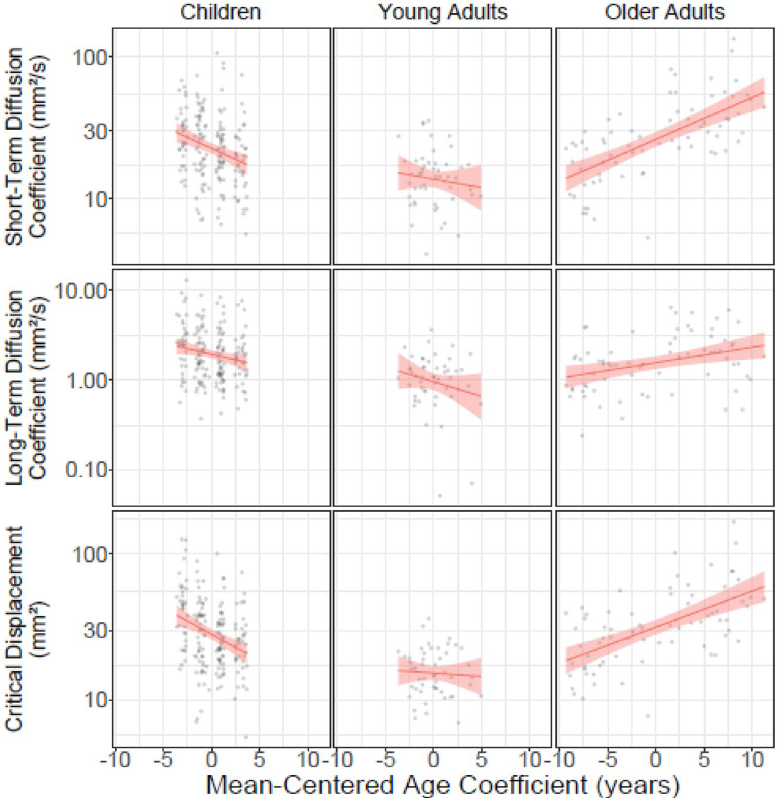
Figure 3. Nested age effects for the short-term diffusion coefficient, long-term diffusion coefficient and critical displacement. Error envelope = ±